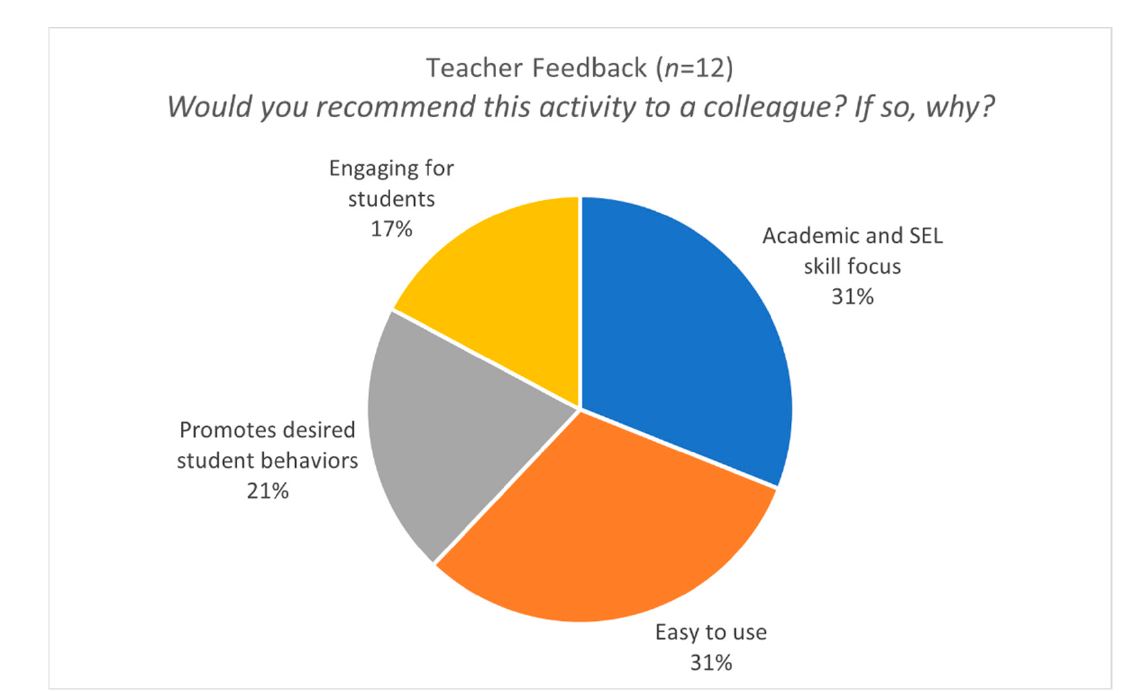
Figure 2. Summary of teacher reasons for recommending activities to colleagues.